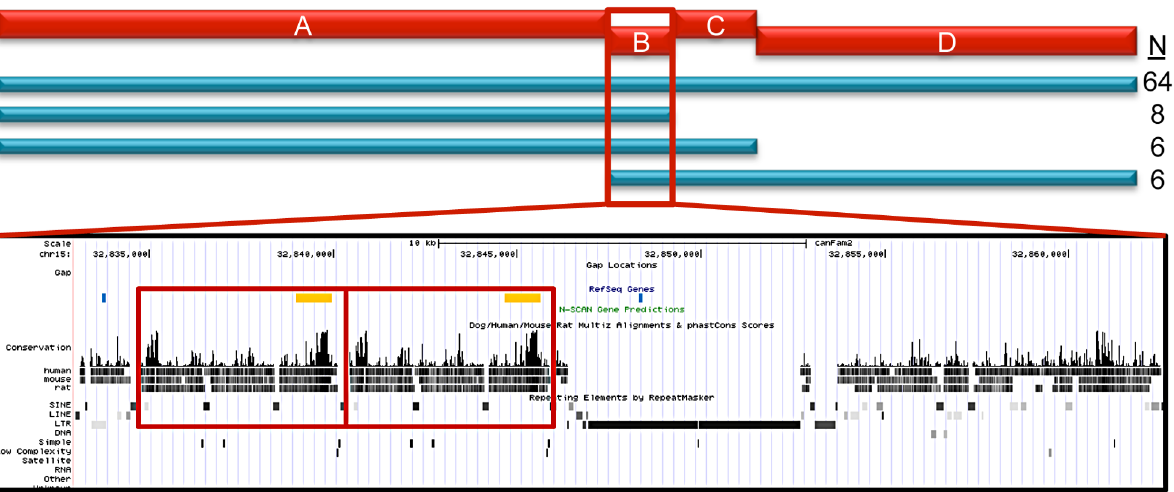
Figure 5. STPO cases narrow the region to 28.3 Kb. The red bars represent the four LD blocks in the 144.9 Kb region, termed A through D. The haplotype mapping results derived from 84 STPO cases are indicated by the blue bars, with the number of cases indicated on the right. The majority of STPO cases (n=64) share at least one copy of the same haplotype within blocks A, B, C and D. Eight cases share in LD blocks A and B, six cases share in LD blocks A, B and C, and another six cases share in LD blocks B, C and D. The conservation and repeat elements in the reference genome for the 28.3 Kb from the end of block A to the beginning of block C are shown. The red boxes indicate the two copies of the 5.7 Kb element. Within the RefSeq Genes track, the blue lines are the PstI sites surrounding the CNV and the orange boxes are the locations of the probe used for the Southern blot. doi:10.1371/journal.pgen.1003409.g005 PLOS Genetics |